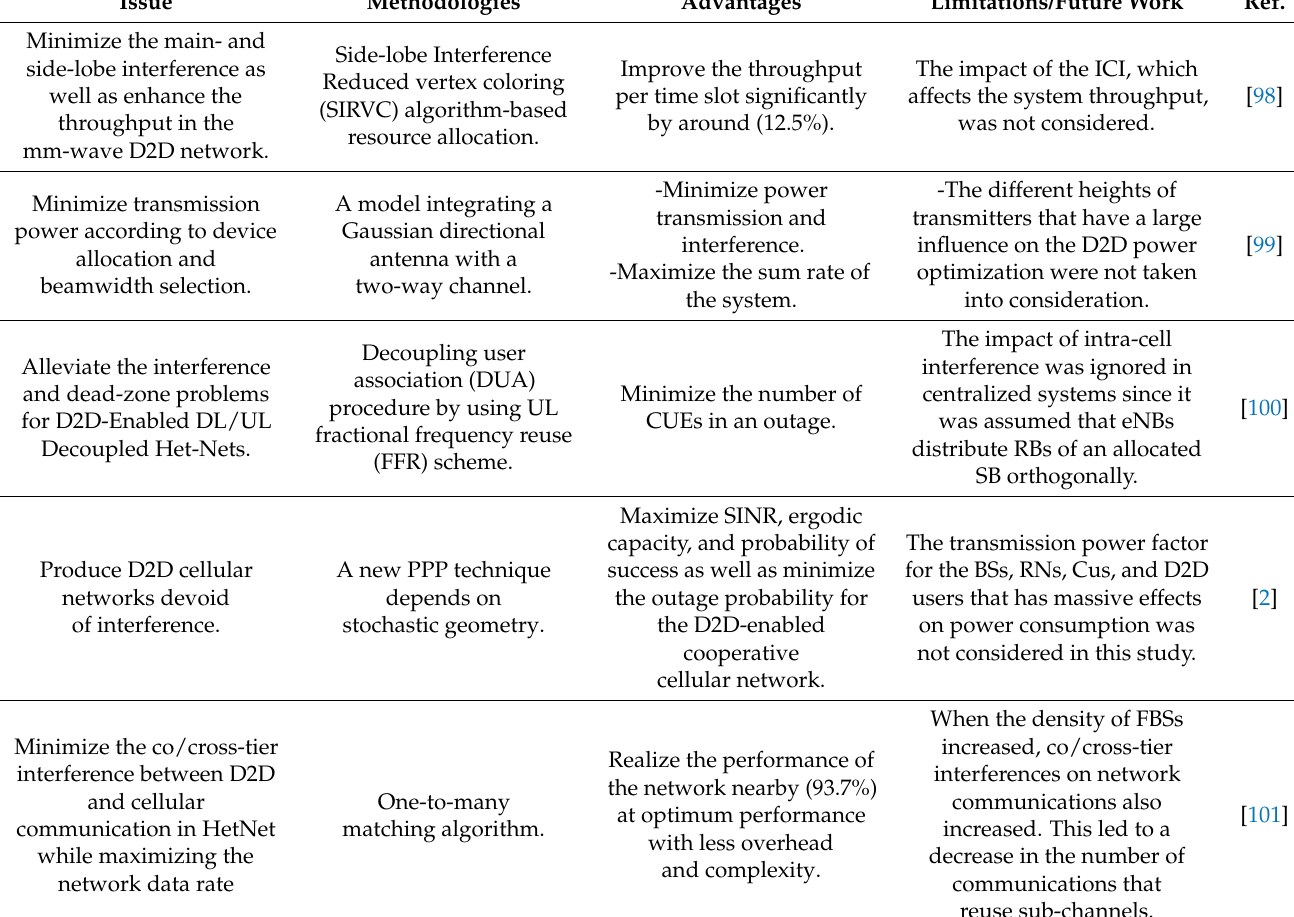
Table 3. The summary of previous studies of D2D in the